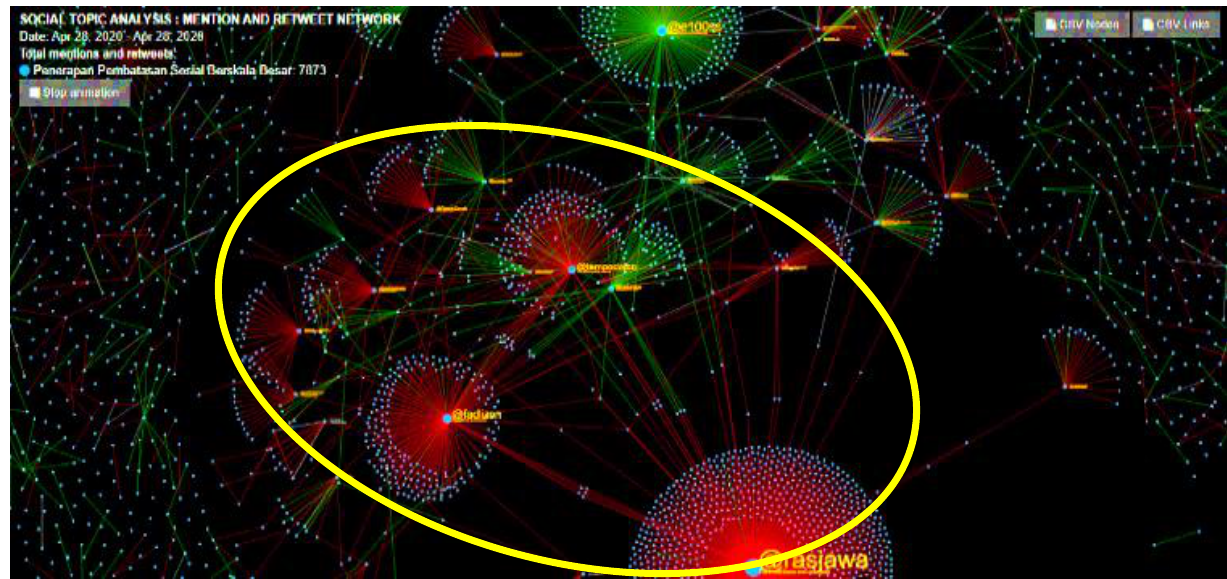
Figure 7. Social Network Analysis on 28 April 2020; the condition was recorded at 10:59 a.m.